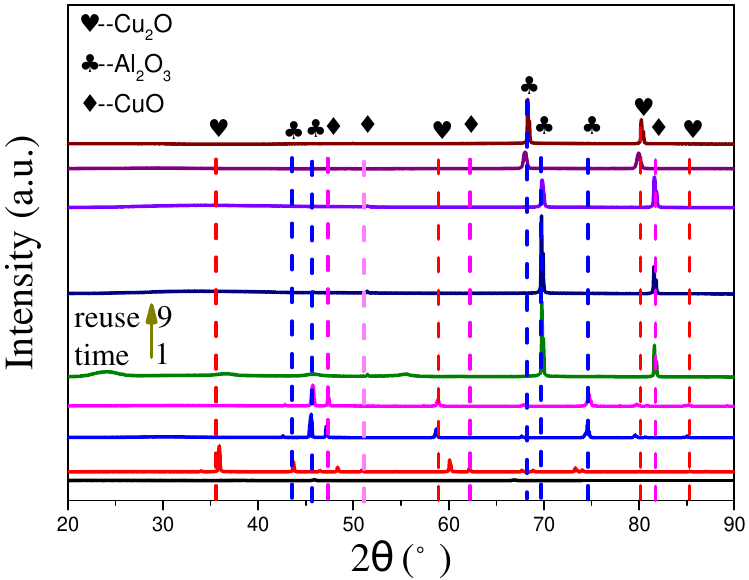
Figure 10. X-Ray diffraction (XRD) patterns of Cu 2 O/Al 2 O 3 coating after nine reuse times. An X-ray diffractometer was used to study the crystalline structure of the Cu 2 O/Al 2 O 3 coating at different reuse times. Results are shown in Figure 10. It can be seen from Figure 11 that at about 36 ◦ , 58 ◦ , 80 ◦ and 85 ◦ , there are Cu (I) oxide characteristic peaks, at about 42 ◦ , 45 ◦ , 68 ◦ 70 ◦ and 75 ◦ there are Al 2 O 3 characteristic peaks, and at about 47 ◦ , 52 ◦ , 62 ◦ and 82 ◦ , there are Cu (II) oxide characteristic peaks. It can be seen from Figure 9a–i that with the increase of reuse times, the peak intensity of Cu (II) oxide increases, while the peak intensity of Cu (I) oxide decreases, showing that some Cu (I) oxide in the coating is transformed into Cu (II) oxide. The main reason is the Cu (I) oxide in the coating is a metastable oxide. During the process of CPWO, with the action of H 2 O 2 some Cu (I) oxide is transformed into Cu (II) oxide. Because Cu (I) oxide is the active species for degradation of methyl orange, the catalytic activity of the Cu 2 O/Al 2 O 3 coating decreases with the decrease of Cu (I) oxide. Therefore, the degradation rate of methyl orange decreases with increasing reuse times.